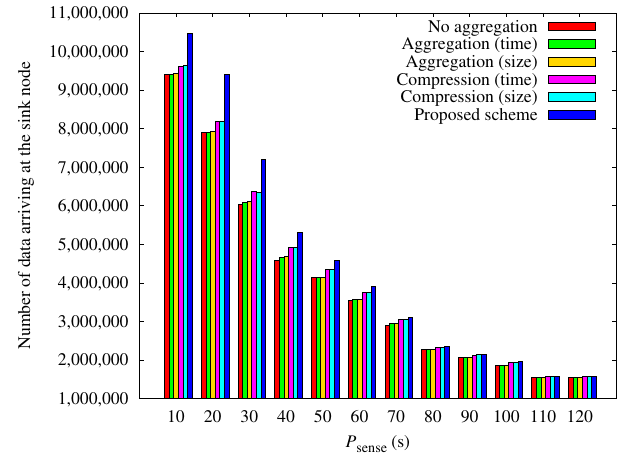
Figure 12. Comparison of the amount of data obtained according to the sensing period.